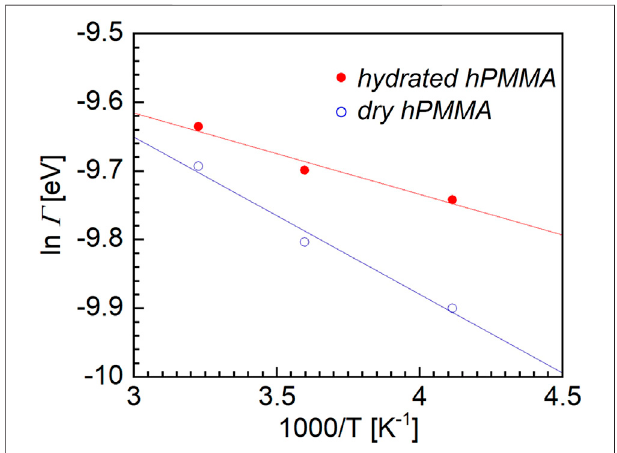
FIGURE 4 | Semilogarithmic plot between the half width at half maximum ( Γ ) of the Lorentz function, versus the reciprocal of the absolute temperature for the dry hPMMA and hydrated hPMMA